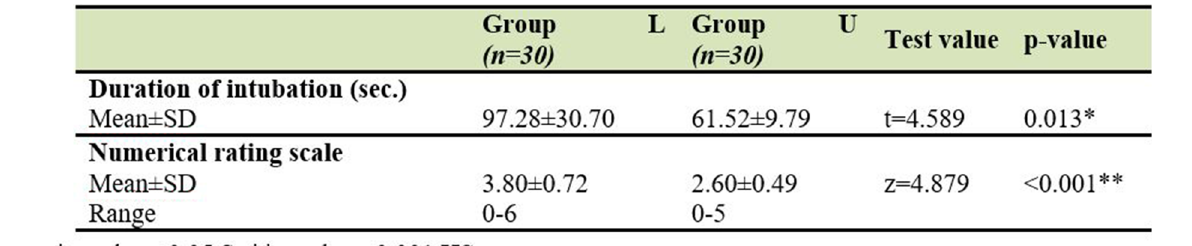
Table 4 Comparison between group L and group U as regards the duration of intubation and numerical rating scale for perception of pain and discomfort during intubation 12 h